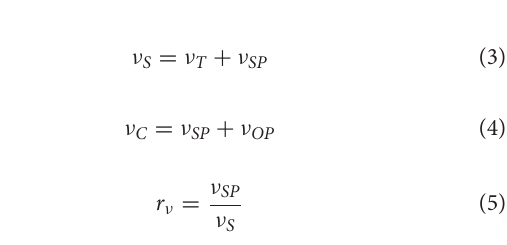
FIGURE 1 | Summary of most subduction zone parameters showing their respective box plot